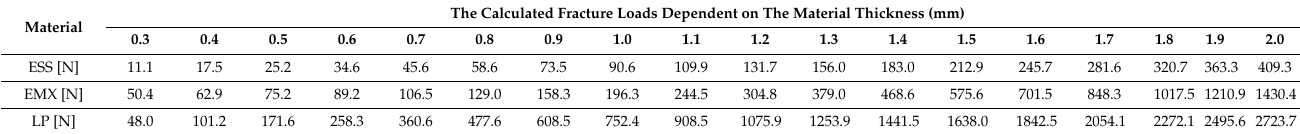
Table 5. The calculated fracture loads for the three materials